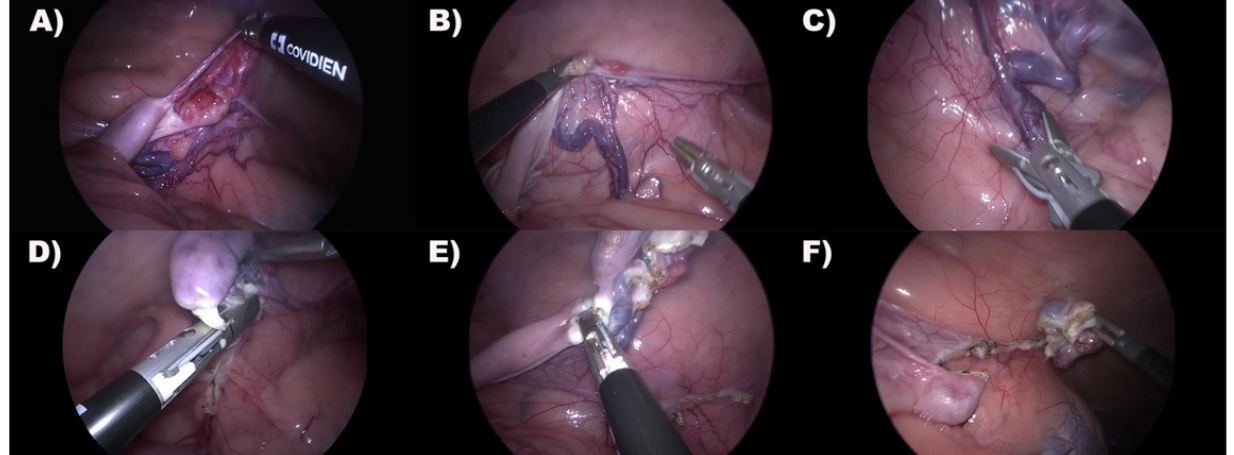
Figure 4. Representative laparoscopic images of right ovariectomy. Caudal is on the left. ( A ) Ovary inspection. ( B ) The ovary was grasped and suspended for ovarian vessel bound visualization. ( C ) The ovarian vessel bound was clamped with the vessel-sealing device axially for complete dissection. ( D ) The mesovarium was dissected with the vessel-sealing device. ( E ) The uterine horn was clamped and coagulated at the level of proper ovarian ligament with vessel-sealing device. Many coagulation cycles were applied to complete dissection. ( F ) Complete Ovary dissection.